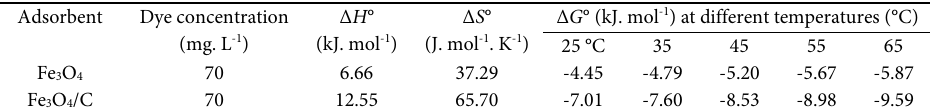
Table 3: Thermodynamics parameters for adsorption of MB on to magnetic nano-adsorbents Adsorbent